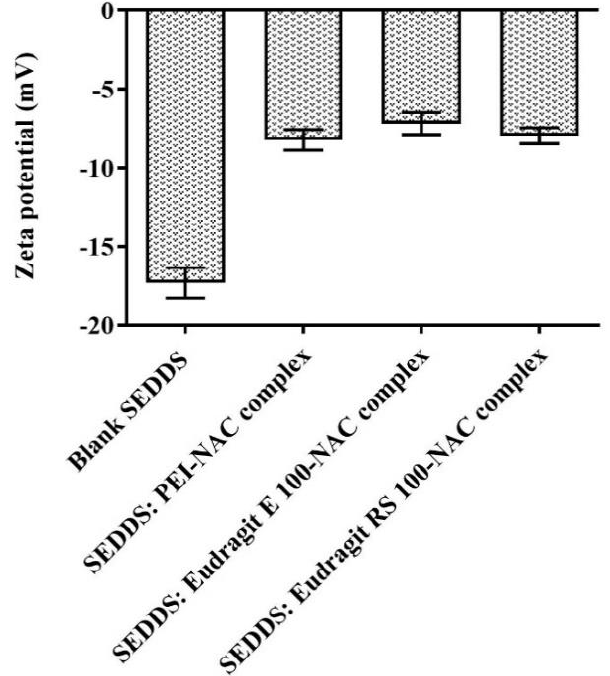
Figure 5. The average values of the zeta potential of 1:100 diluted SEDDSs showing a blank SEDDS and SEDDSs of polymeric NAC ionic complexes determined in phosphate buffer with 10 mM ionic strength at pH 6.8 at 37 °C. The values given are the means ± standard deviations ( n ≥ 3).